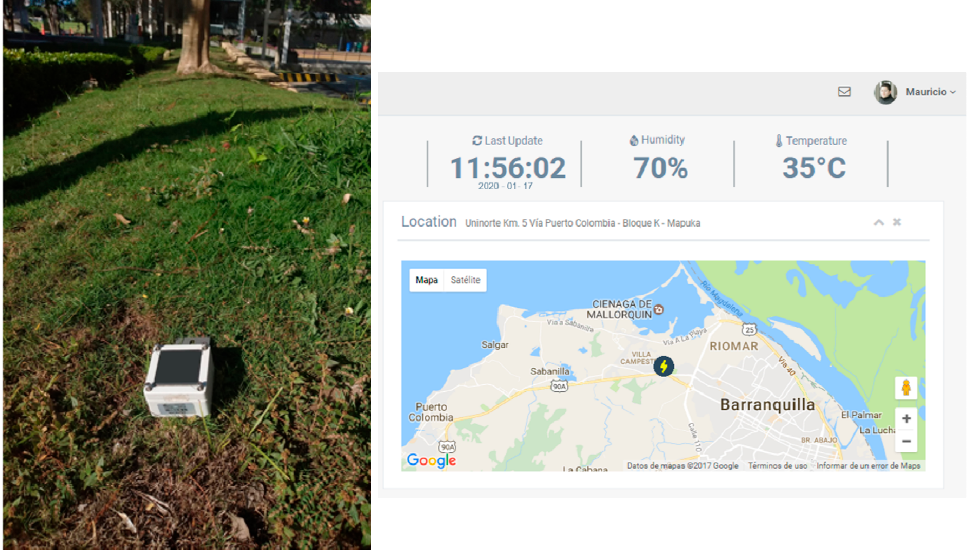
Figure 22. Complete prototype comprised of IoT sensor and Graphical User Interface.